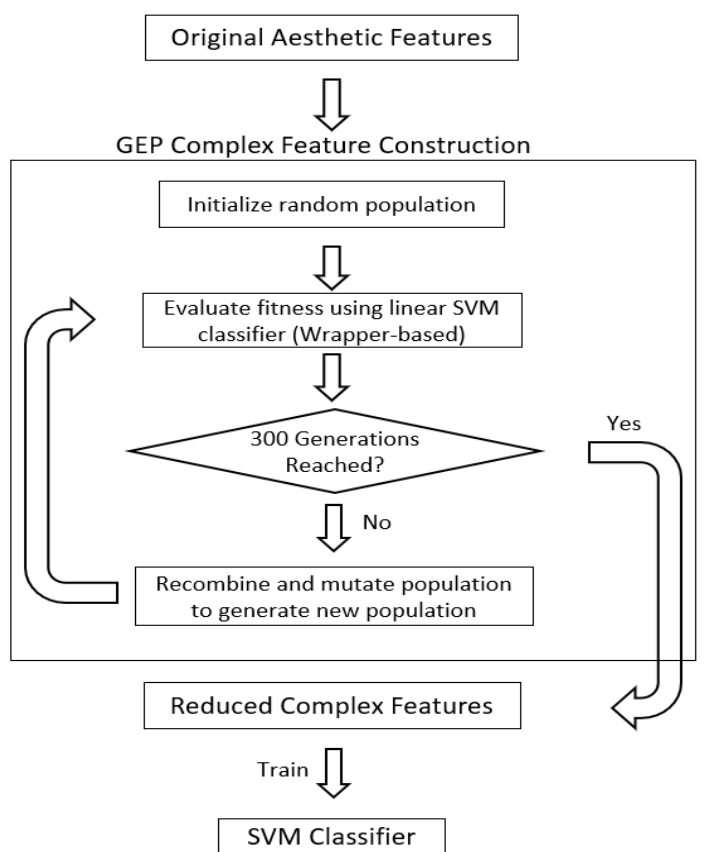
Figure 4. The flowchart for the Gene Expression Programming method for feature selection and